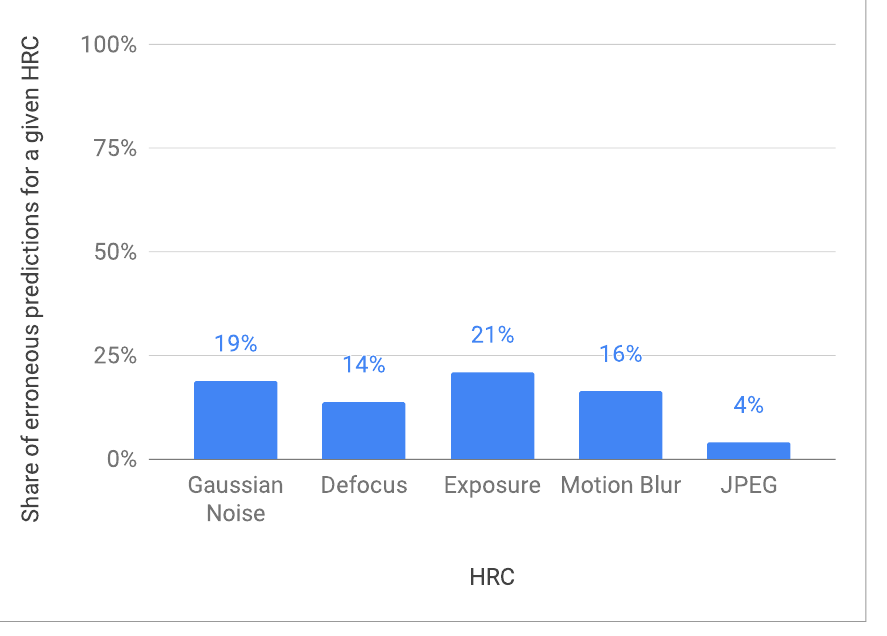
Figure 23. Share of erroneous predictions for a given Hypothetical Reference Circuits (HRC) in face